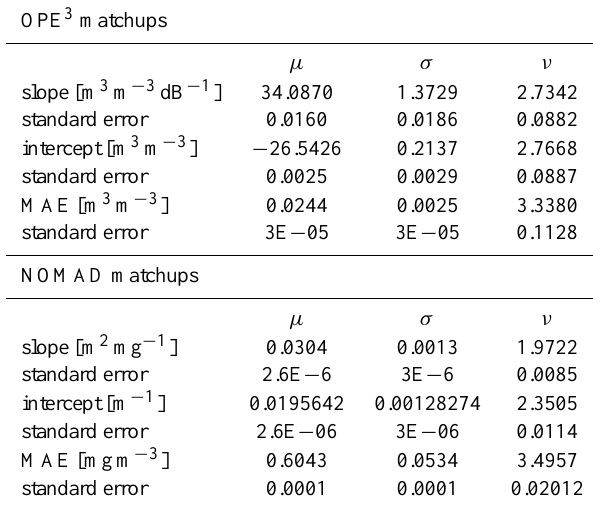
Table 1. Estimated parameters of the best fit t -location-scale distri- bution to model coefficients and MAE uncertainties. The degree of fit is expressed in standard